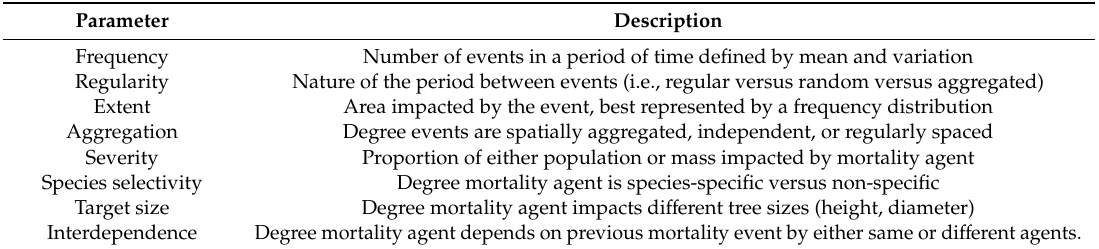
Table 1. Key parameters needed to describe di ff erent mortality